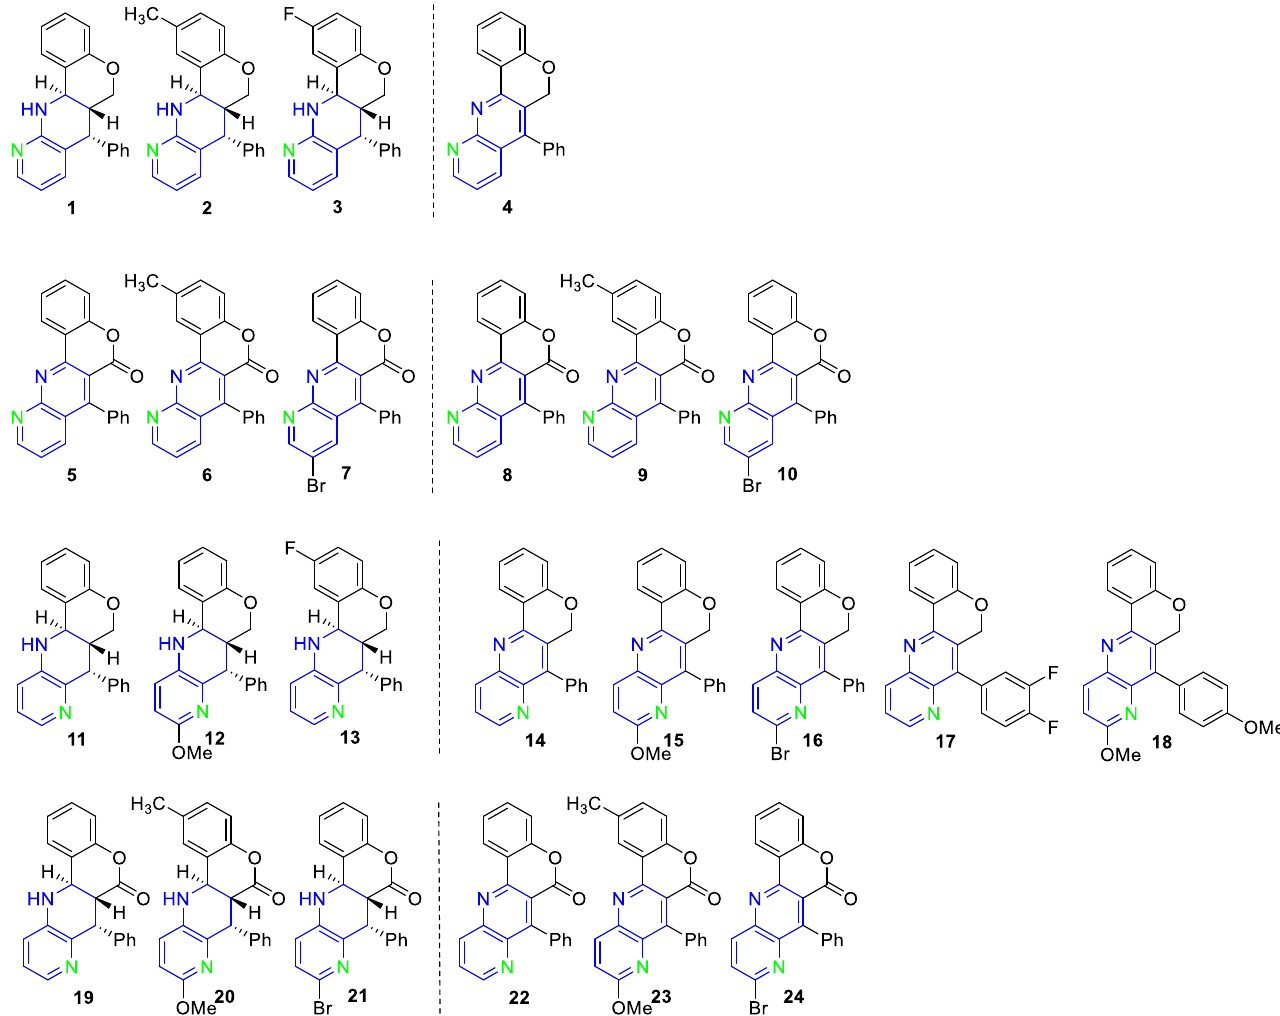
Figure 2. Different families of fused naphthyridines evaluated as antiparasitic agents against Naegleria fowleri . Compounds 1 – 4 correspond to 1,8 naphthyridines fused with chromene. Compounds 5 – 10 are 1,8 naphthyridines fused with chromenone rings. Compounds 11 – 18 correspond to 1,5 naphthyridines fused with chromene. Compounds 19 – 24 are 1,5 naphthyridines fused with chromenone.